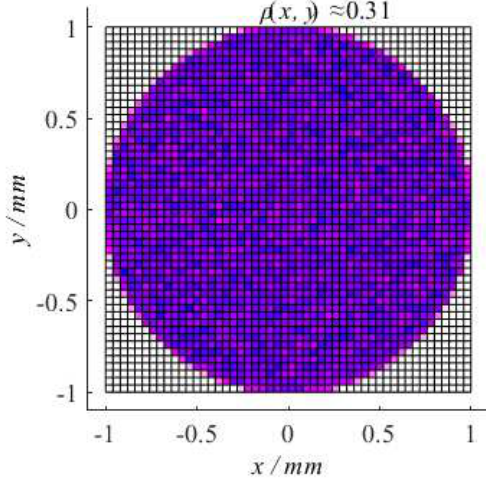
Figure 15. The probability density simulation of a clearance joint.